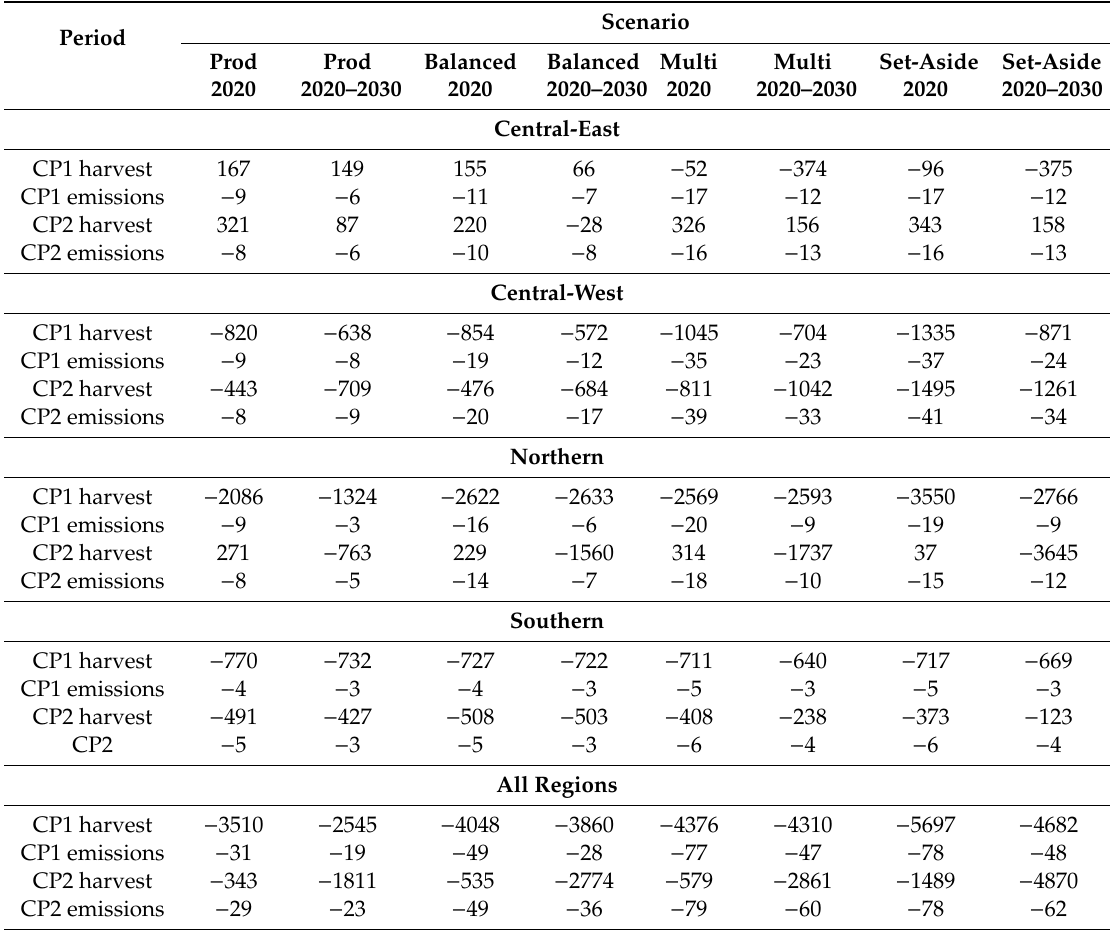
Table 5. Deviation of annual roundwood harvest and net forest emissions from BAU-only scenario in the considered scenarios, in thousand m 3 / year (overbark) and Mt CO 2 / year, respectively, in the studied regions averaged for CP1 and CP2 (a positive number for the harvest implies that the harvest is larger in the considered scenario as compared to the BAU-only scenario, and a negative number for the emissions implies that the emissions are lower (i.e., the sink is larger) in the considered scenario as compared to the BAU-only scenario). (Prod = production, Multi = multifunction).